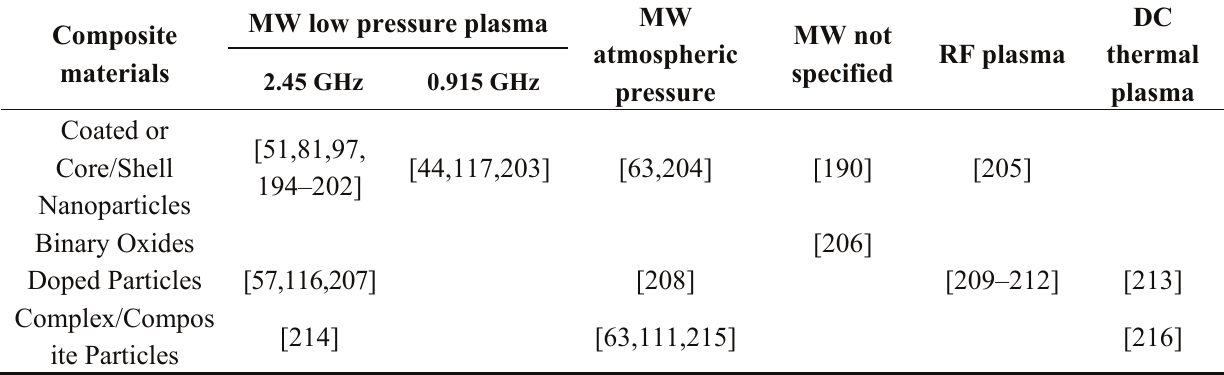
Table 6. Overview on published papers related to the subject of composite nanoparticles, synthesized in microwave